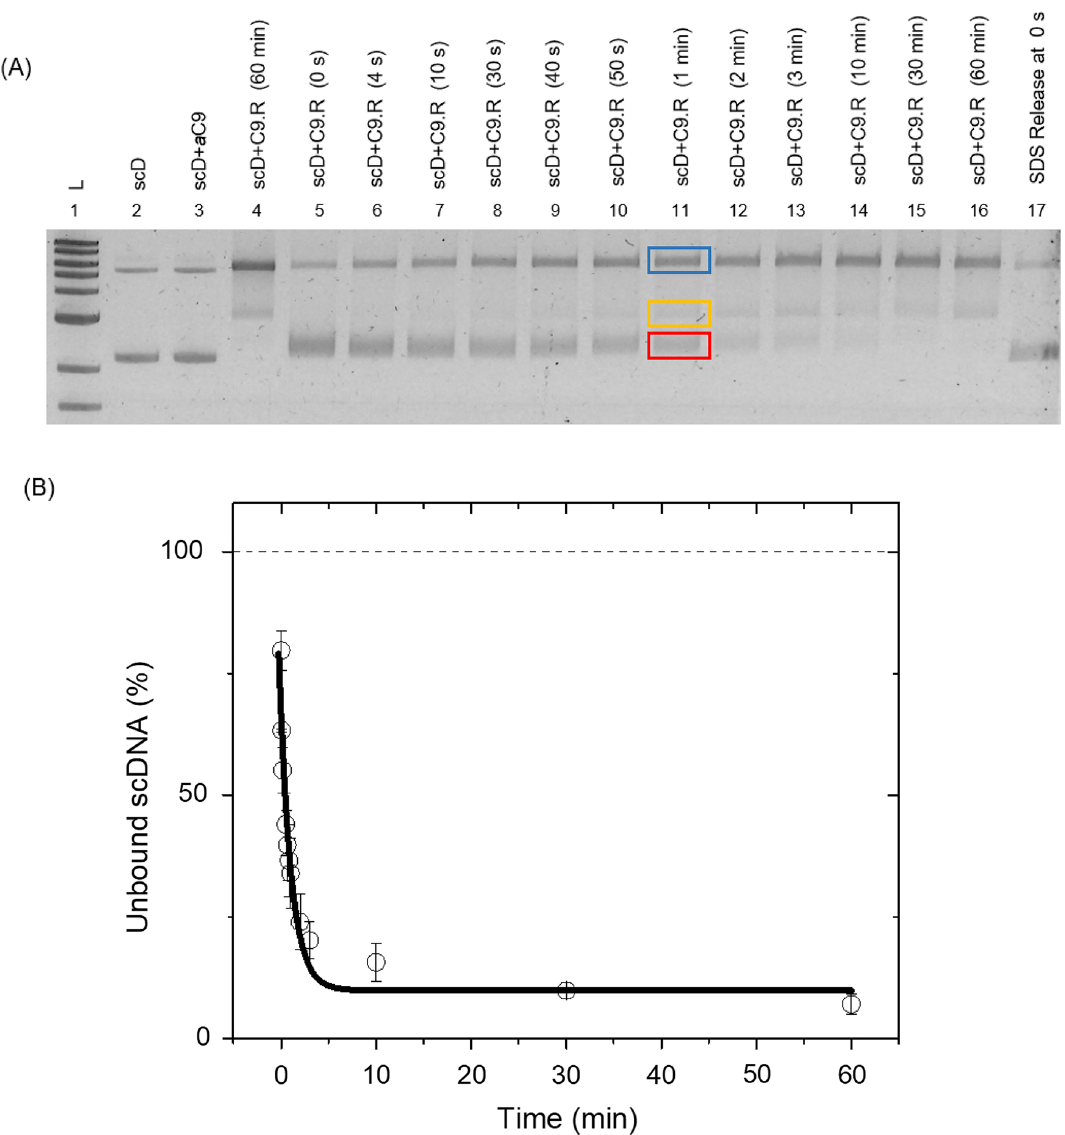
Figure 2. Time dependence of Cas9 binding to target DNA. ( A ) The gel shows the binding of Cas9 to the target DNA as a function of time and the subsequent arrest of the bound product with EDTA. Lane1: 1 kb ladder, lane2: control DNA, lane3: DNA + apo -Cas9 at 37 °C, lane4: Cas9.RNA bound to the target DNA at 37 °C for 60 min which is the binding control. Lanes 5–16 show the binding of Cas9.RNA to the target DNA at 0 s, 4 s, 10 s, 30 s, 40 s, 50 s, 1 min, 2 min, 3 min, 10 min, 30 min, 60 min respectively. Lane 17 shows the SDS release of target DNA at 0 s to confirm no linear DNA is released. The blue, yellow and red boxes in lane 11 represent the typical positions for bound, released and the unbound gel bands used for DNA quantification. ( B ) Shows quantification of the Cas9 binding rate constant from the gel band intensities of the unbound supercoiled DNA in lanes 5–16 respectively. (k bind = 0.8 ± 0.2 min −1 ) Solid line is fit to Eq. (1). The mean and error bars are from N = 3 independent experiments (the repeated experiments are shown in Fig.